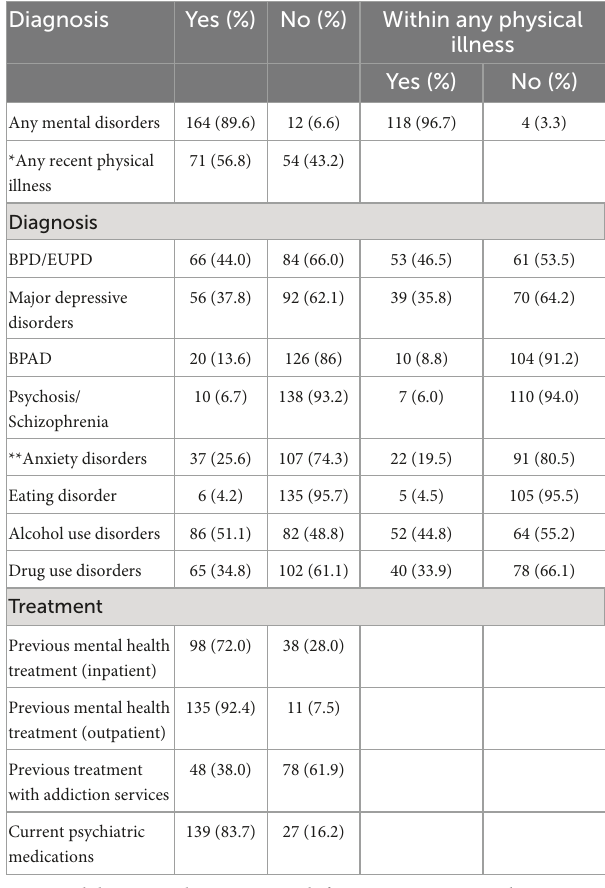
TABLE 3 Mental disorder, physical illness, and treatment details of the participants in file review